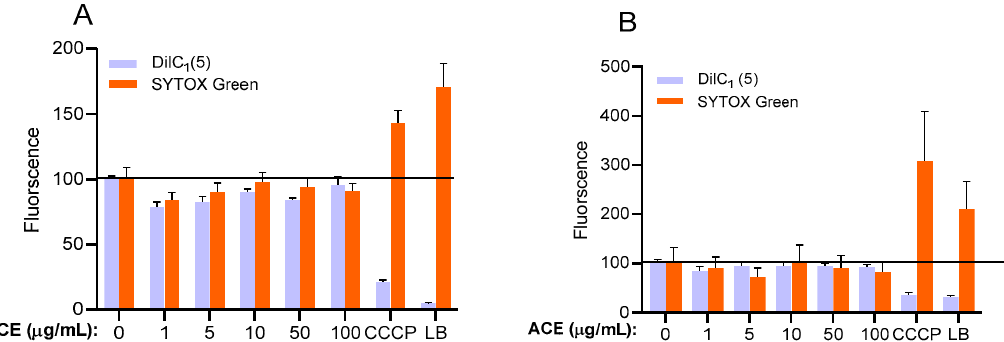
Figure 4. Combined fluorescent DilC 1 (5) and SYTOX Green labelling. To observe apoptotic and necrotic cell death, HUVECs were treated as indicated ( A ) 24 h or ( B ) 48 h. Results are expressed in the percentage of the control (100% is represented by the solid lines). Data are expressed as the mean ± SEM of four individual experiments. CCCP, carbonyl cyanide m-chlorophenyl hydrazone (positive control for apoptosis); LB, lysis buffer (positive control for necrosis); ACE, anthocyanin extract.